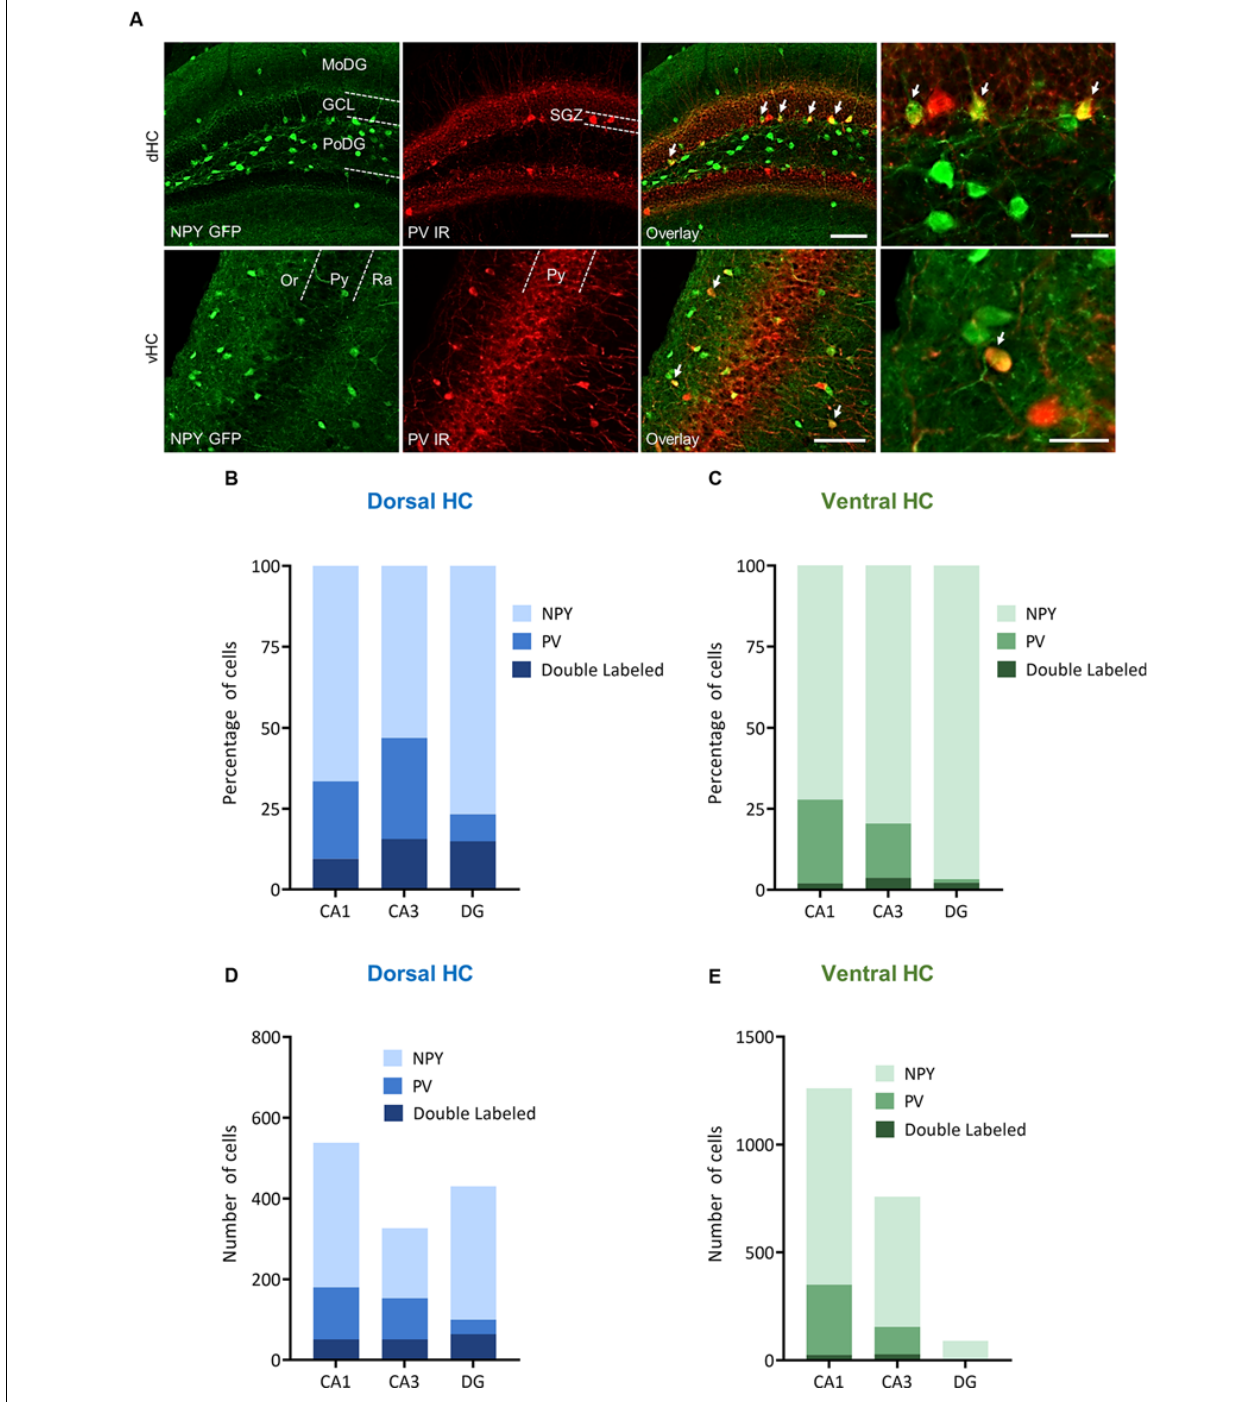
FIGURE 7 | Distribution and quantification of co-expression of parvalbumin (PV) with NPY in the dorsal (dHC) and ventral (vHC) mouse hippocampus. (A) Immunohistochemical labeling for PV and NPY-GFP auto-fluorescence depicting dual-labeled neurons (upper panel: dorsal dentate gyrus, lower panel: ventral hippocampus CA1, arrows depict dual-labeled neurons) of NPY-GFP mice. Cells in green indicate NPY-GFP + neurons and cells in red indicate PV expressing neurons. (B) Histograms showing the percentage of NPY-GFP neurons in CA1, CA3, and DG of the dorsal hippocampus that are co-labeling with PV. (C) Histograms showing the percentage of NPY-GFP neurons in CA1, CA3, and DG of the ventral hippocampus that are co-labeling with PV. In the ventral hippocampus the amount of NPY and PV dual labeling is very low. (D) Number of NPY-GFP and PV neurons in CA1, CA3, and DG of the dorsal and (E) ventral hippocampus. Scale bars: lower magnification 200 µ m (third column), higher magnification 50 µ m (last column). Abbreviations: MoDG, Molecular layer of the dentate gyrus; GCL, granule cell layer; PoDG, hilus/polymorph layer of the dentate gyrus; SGZ, subgranular zone; Or, stratum oriens; Py, stratum pyramidale; and Ra, stratum radiatum.